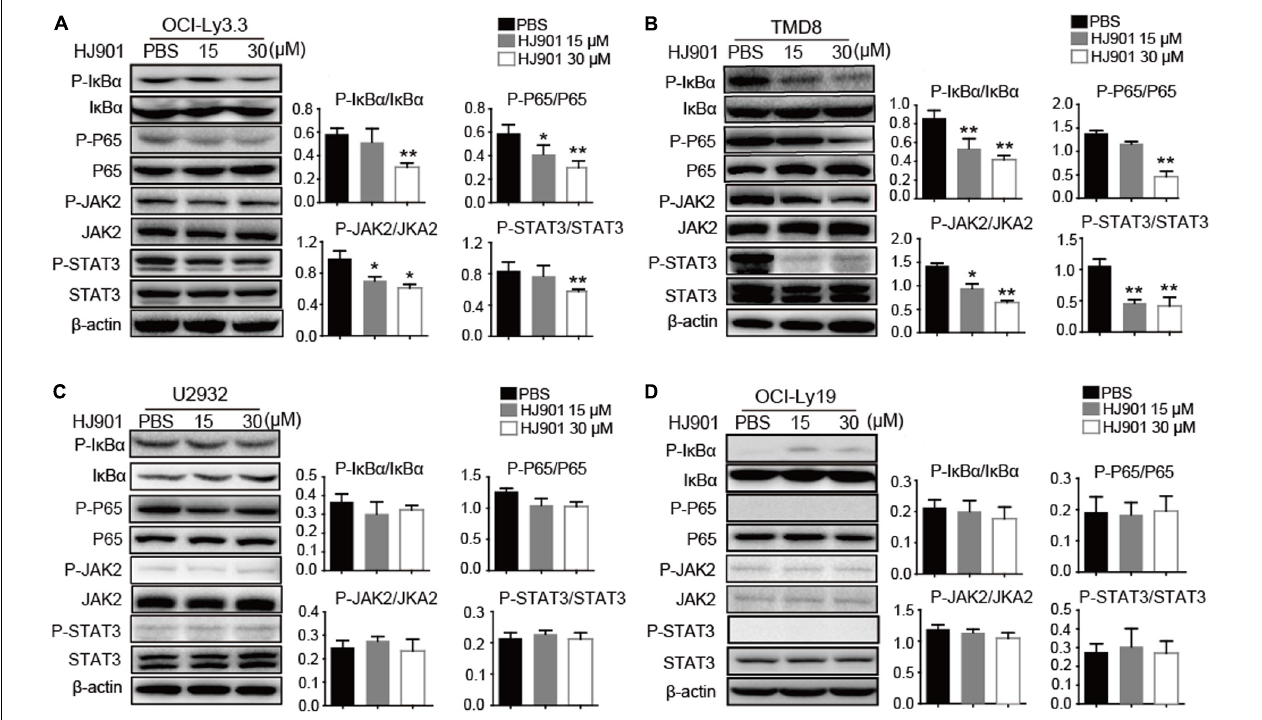
FIGURE 6 | Inhibitory effect of HJ901 on NF- κ B and JAK2-STAT3 pathways in vitro . (A–D) All cells lines were treated with or without HJ901 (15 or 30 µ M) for 24 h and cell lysates were prepared for analysis of P-NF- κ B/NF- κ B, P-I κ B α /I κ B α , P-JAK2/JAK2, and P-STAT3/STAT3 by western blotting. The effect of HJ901 on the expression of P-NF- κ B/NF- κ B, P-I κ B α /I κ B α , P-JAK2/JAK2, and P-STAT3/STAT3 proteins are shown for these cell lines. Quantification of relative protein expression was performed by densitometric analysis using β -actin as an internal control. Similar results were obtained from three independent experiments. All data are presented as the means ± SEM ( n = 5 in each group). * p < 0.05 and ** p < 0.01 vs. PBS